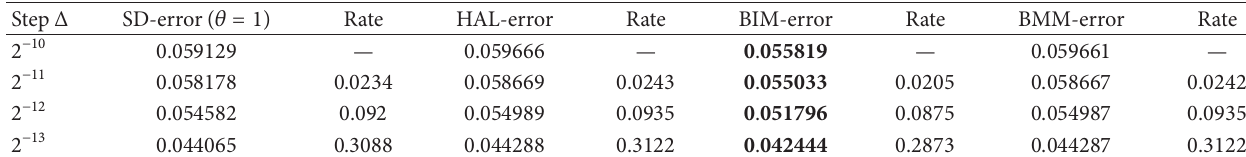
Table 4: 98% error and step size of fully implicit SD, HAL, ALF, BIM, and BMM scheme for (2) with (𝑥 0 , 𝑘 1 ,𝑘 2 , 𝑘 3 ,𝑞,𝑇) = (1/16,1/16, 1, 0.4, 0.55, 1) .